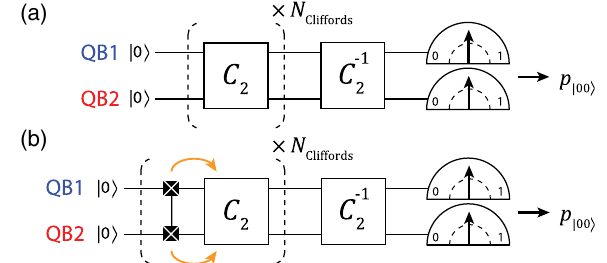
FIG. 28. (a) A diagram of the standard (or reference) two-qubit RB sequence. (b) A diagram of the two-qubit RB sequence interleaved by the iSWAP gate. The additional unwanted Z rotations of the interleaved iSWAP gate are canceled out by the subsequent two-qubit Clifford (orange